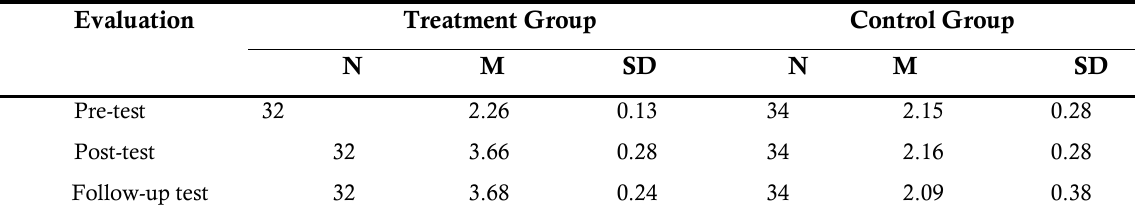
Table 2. Mean of goal orientation behavior means score in experimental and control group between pre-test, post-test and follow-up